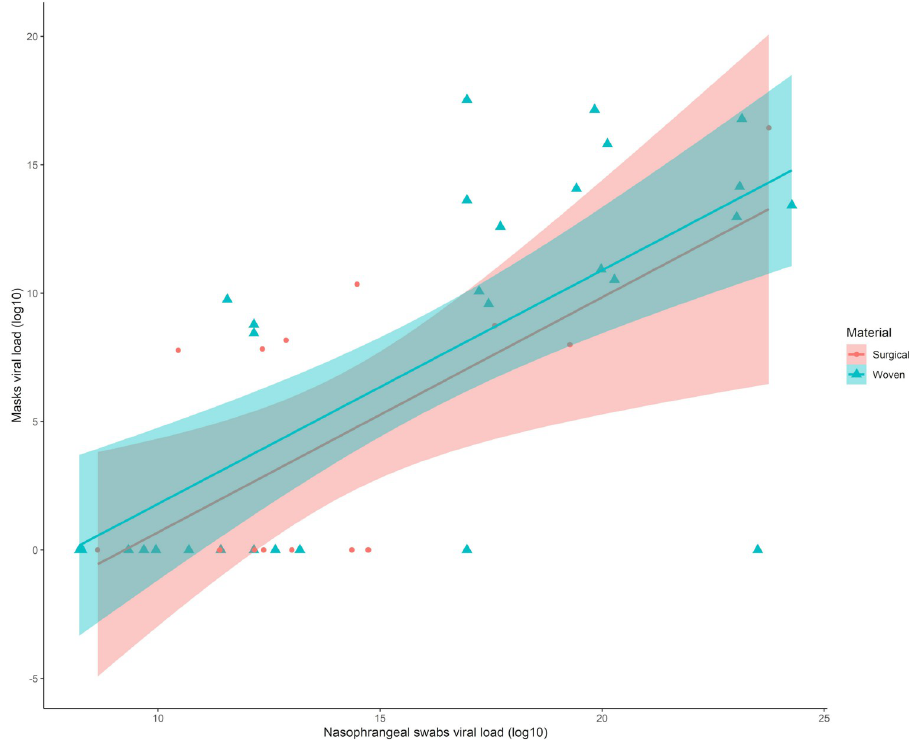
Fig 2. Relationship between severe acute respiratory syndrome coronavirus 2 viral loads of nasopharyngeal swabs and masks used by infected patients.